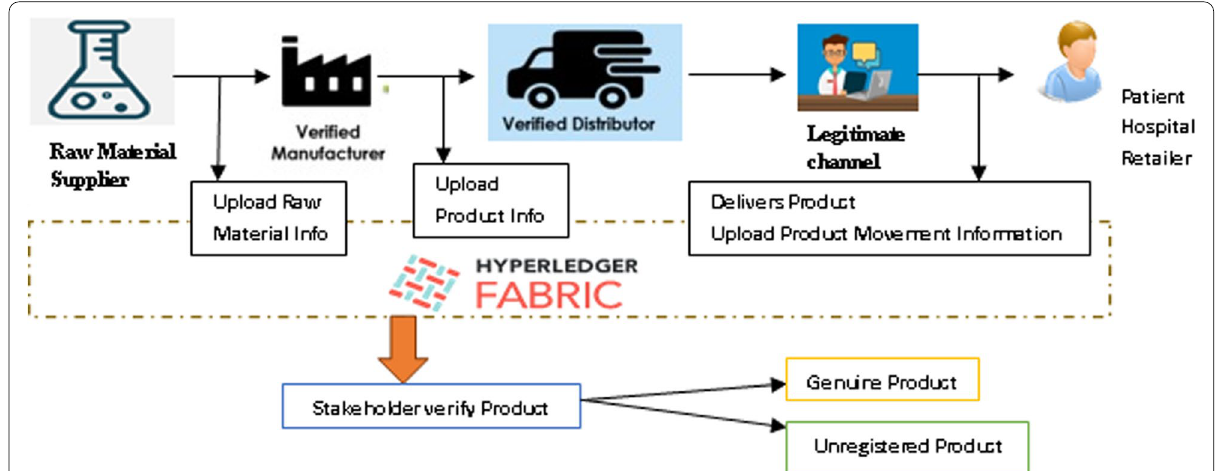
Fig. 3 The Proposed